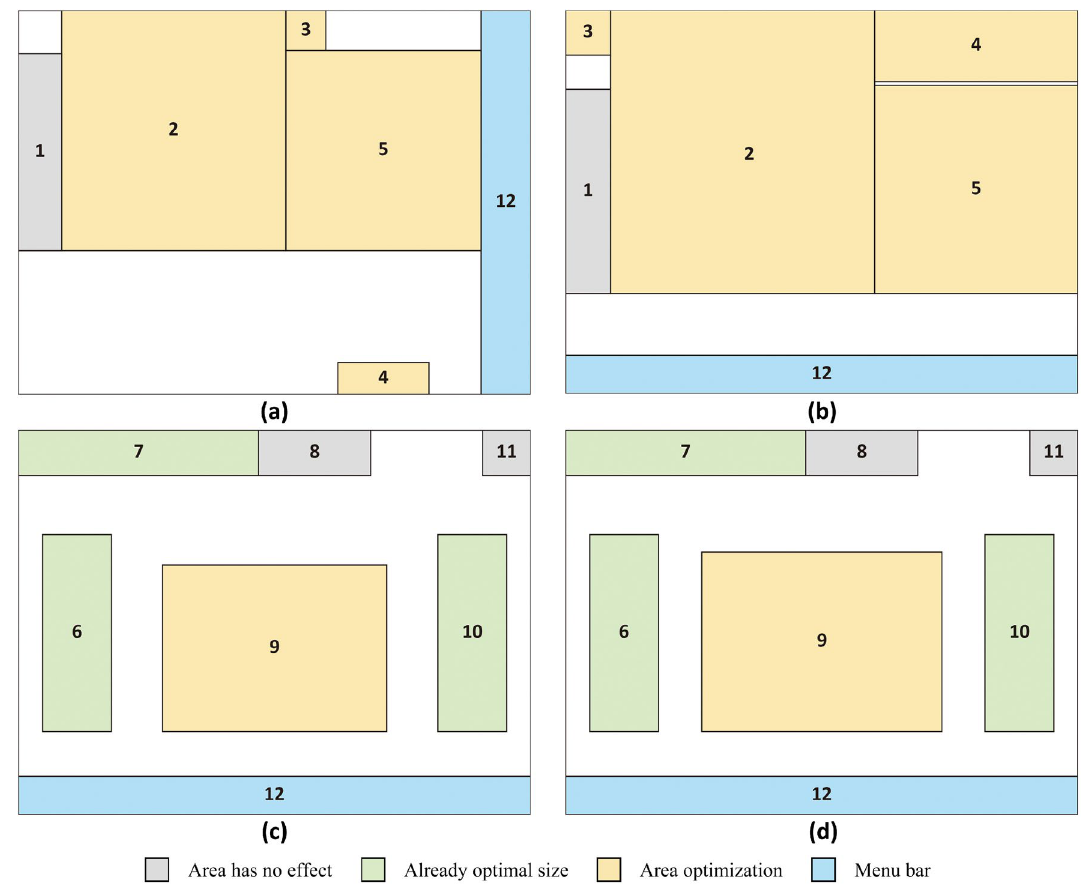
Figure 5. Layout optimization of ATP and TCMS display. ( a ) represents the original layout of ATP, ( b ) represents the layout of ATP after optimization. ( c ) represents the original layout of TCMS, ( d ) represents the layout of TCMS after optimization. 1 is the Target distance, 2 is the Speed control area, 3 is the Locomotive signal, 4 is the Mileage, 5 is the Planning area, 6 is the Electric voltage, 7 is the Data and time, 8 is the Current speed, 9 is the Traction/Braking force, 10 is the Electric current, 11 is the Warning signal, 12 is the Menu